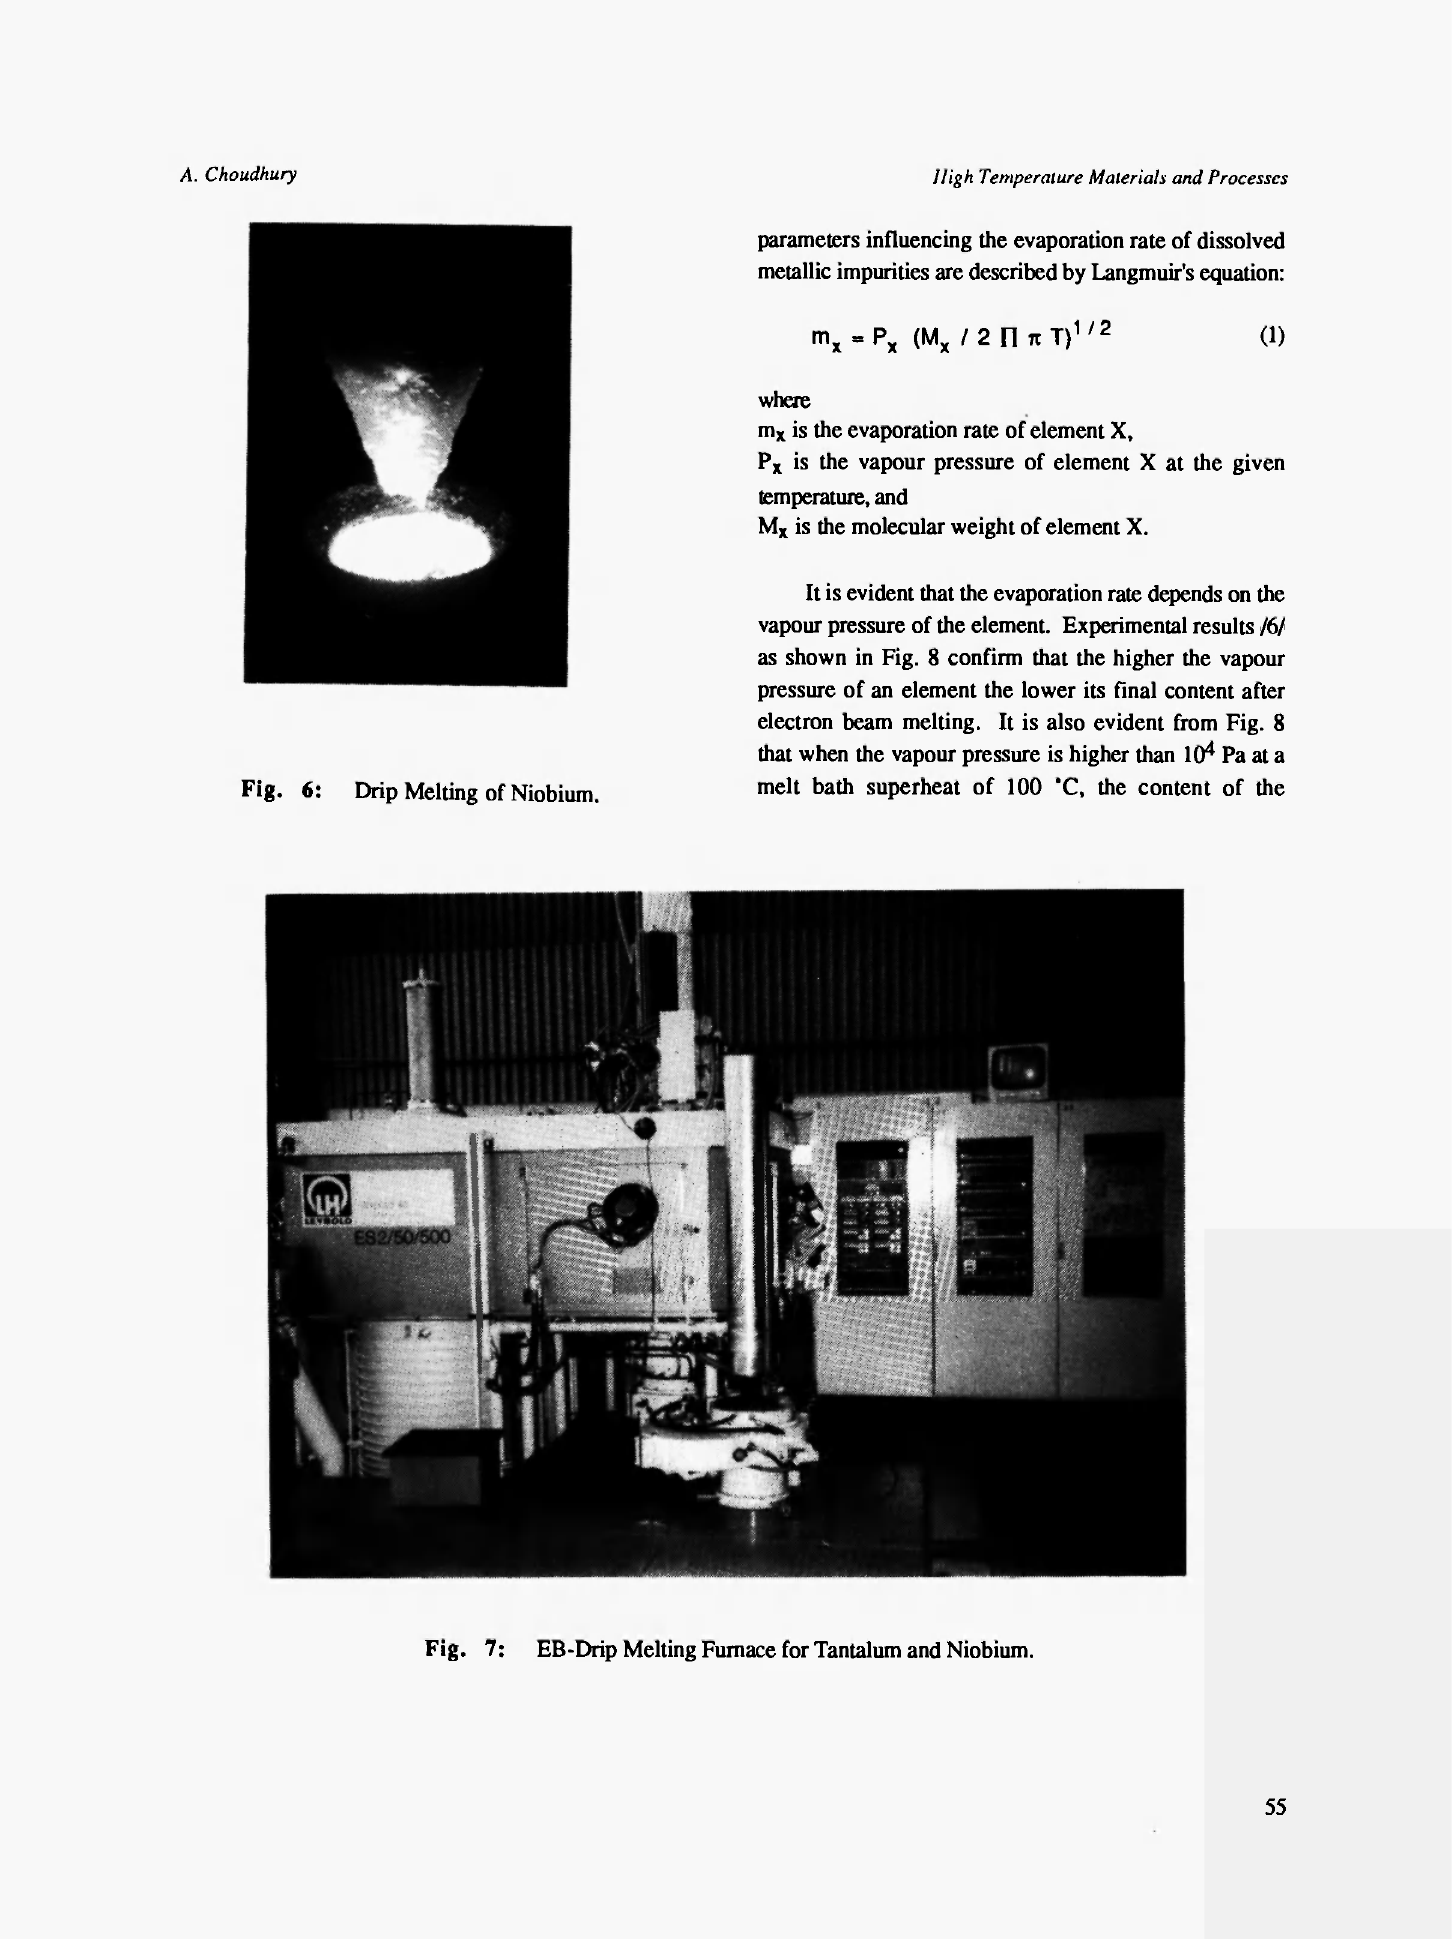
Fig. 7: EB-Drip Melting Furnace for Tantalum and